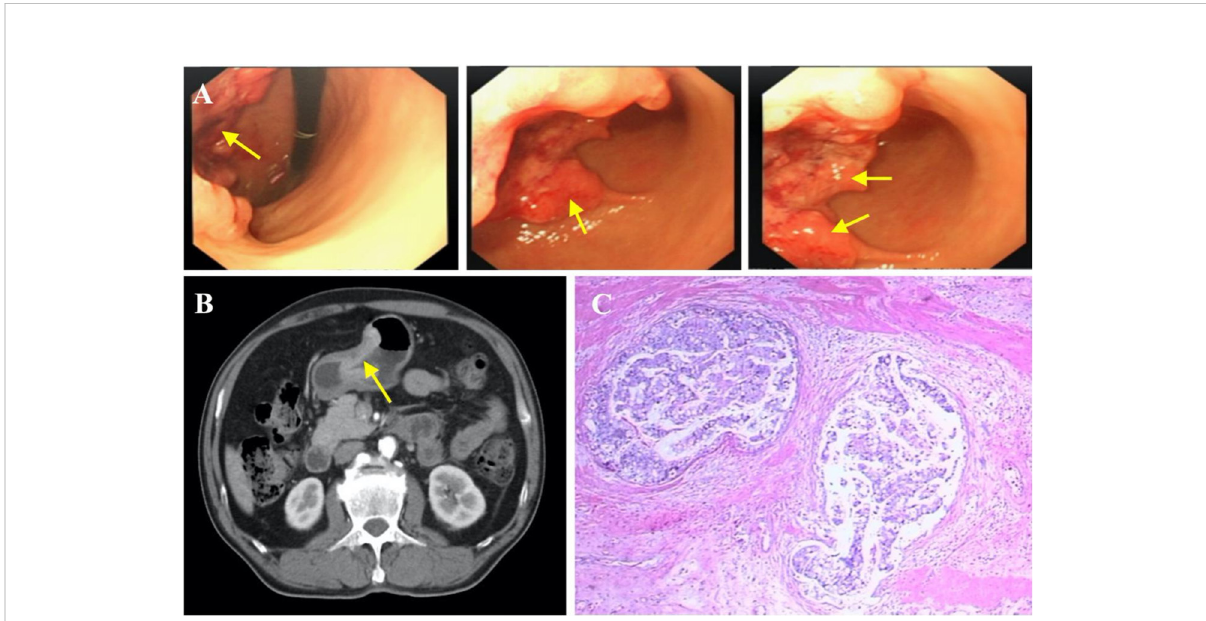
FIGURE 2 Diagnosis of gastric carcinoma. (A) Endoscopic images showing gastric cancer. (B) Gastric cancer (indicated by yellow arrow), speci fi c enhancement pattern on multiphasic contrast-enhanced computed tomography (CT). (C) Representative histopathological image of gastric cancer.